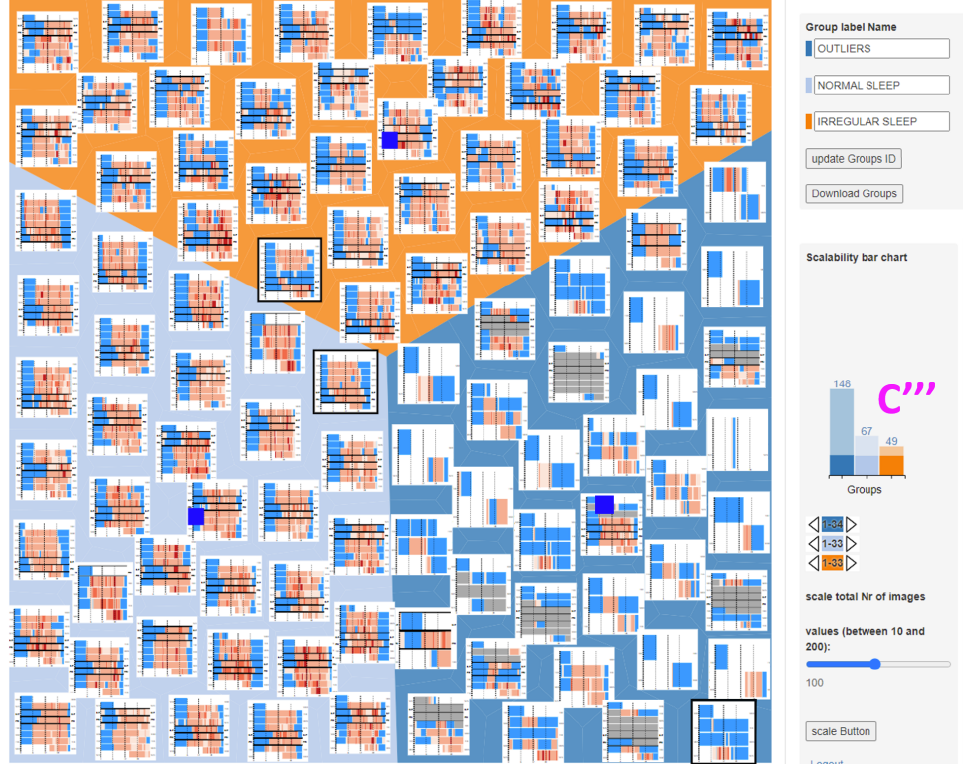
Figure 12. A tree map [48]. The Clinician categorized all images in meaningful groups. The number of visible images is identical for all